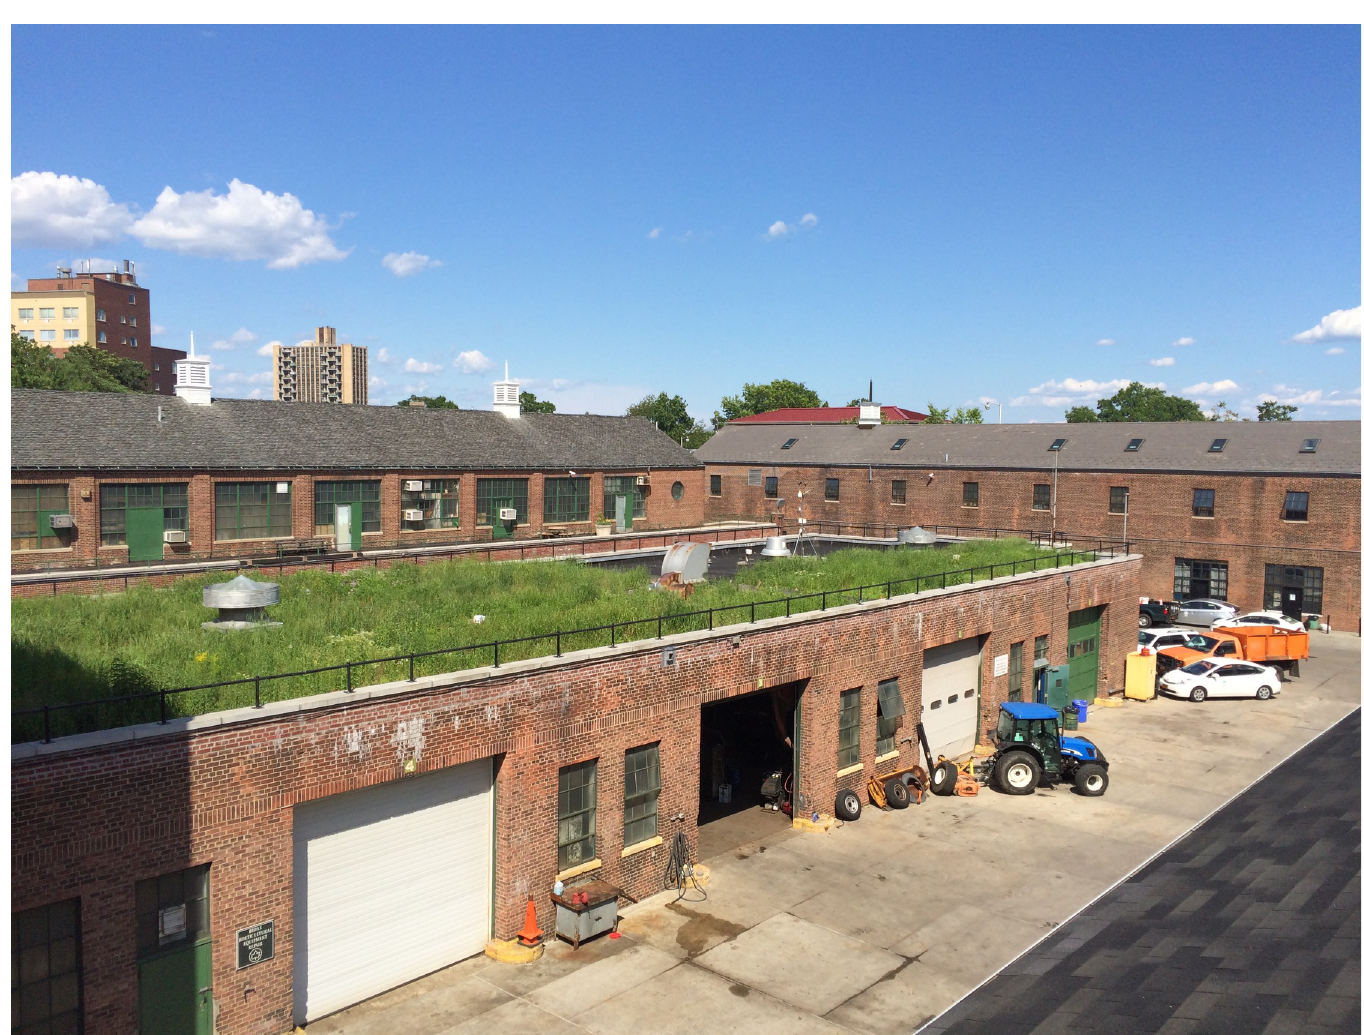
Fig 1. Ranaqua. The green roof is located above a NYC Parks auto garage in the Bronx, NYC.